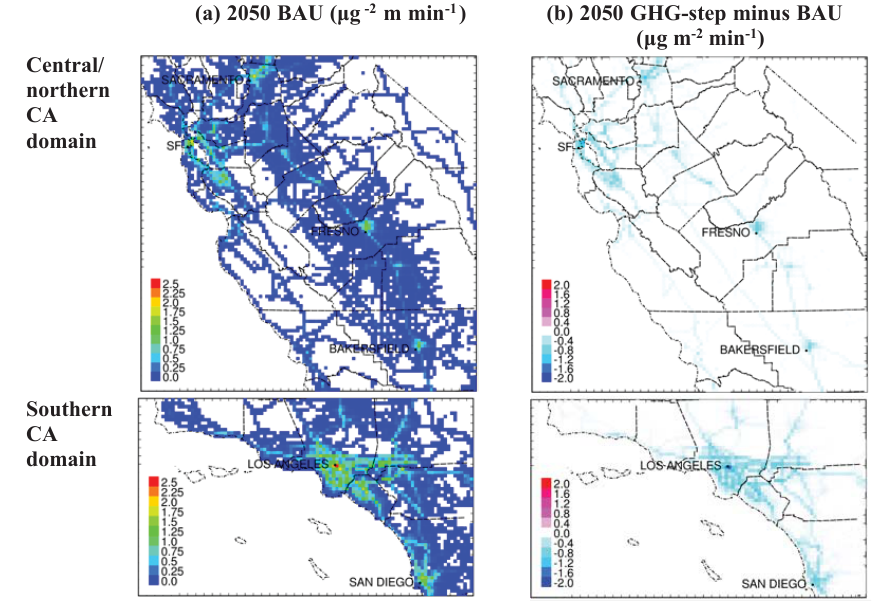
Figure 11. Particulate matter emissions from vehicle tire and break wear in the BAU scenario (a) and emissions change in the GHG-Step scenario (b) . Units are µgm − 2 min − 1 .